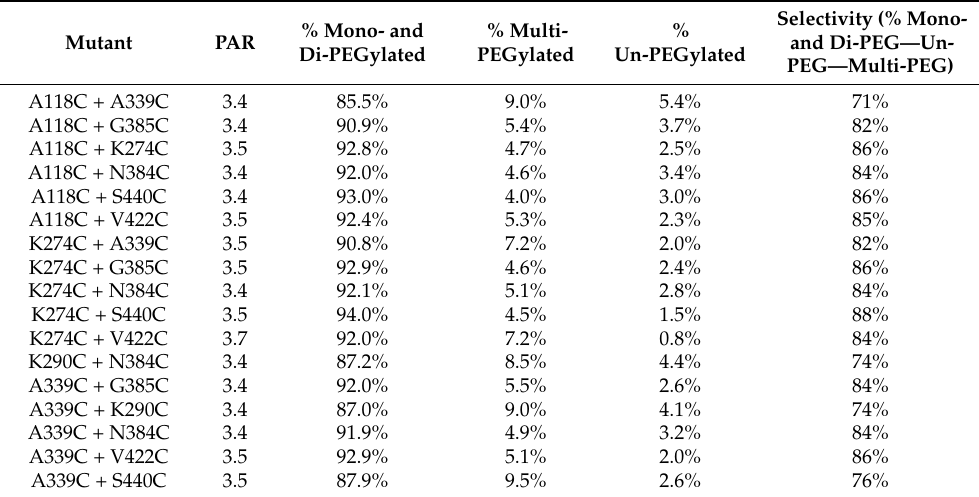
Figure 7. Different conjugation efficiency and selectivity observed among the double cysteine mutants. The double cysteine mutants were analyzed using reducing SDS-PAGE and the gels were stained with Coomassie blue and scanned using ProteinSimple. The PAR ( a ) and percentages of mono- and di-PEGylated ( b ), un-PEGylated ( c ), and multi-PEGylated ( d ) antibody bands were determined with AlphaView software [29]. The red dot lines represent cut offs, and arrows represent top ten double cysteine mutants. Table 3. Top double cysteine mutants identified through PEGylation screening